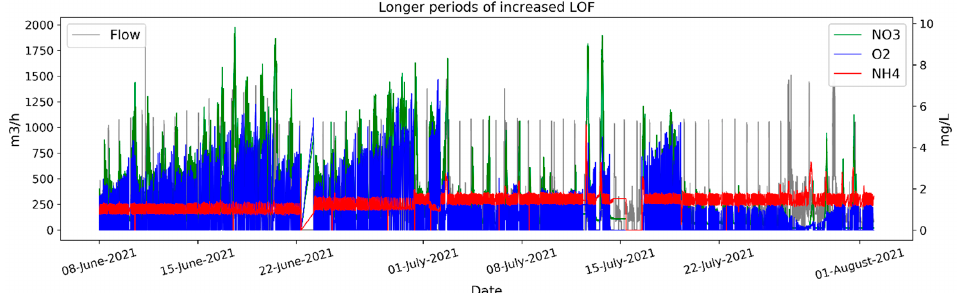
Figure 5. Long period of increased LOF in WWTP2 PCT1. The pattern in the data indicates that the NH 4 sensor had drifted and that the operator of the plant subsequently adjusted the setpoint instead of calibrating the sensor.